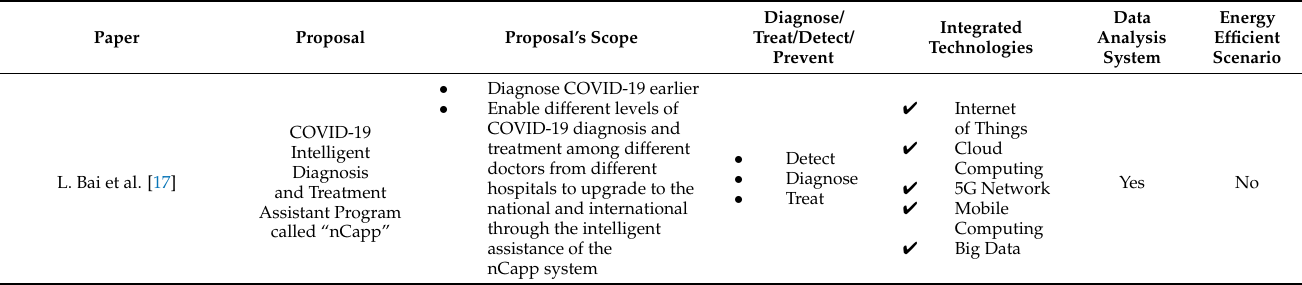
Table 1. Related work comparative